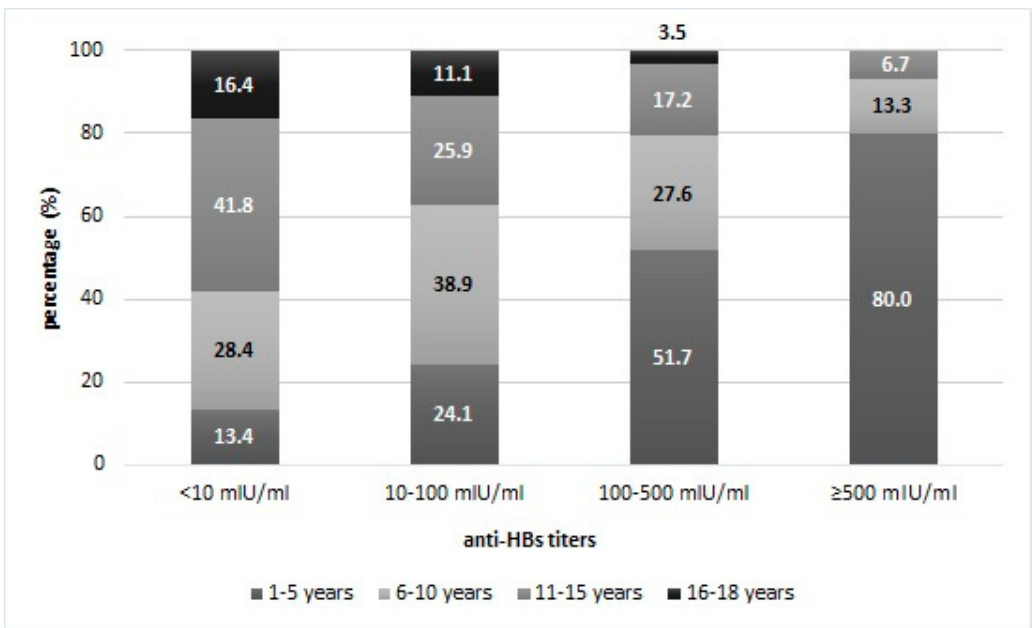
Figure 2. Percentage distribution of subjects of different age groups in the total of immunity levels.